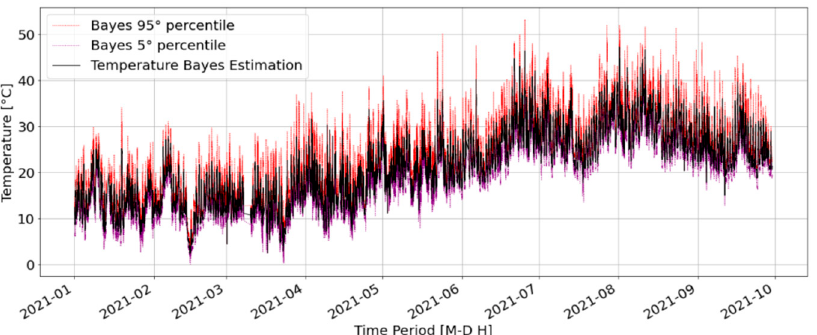
Figure 7. Bayes temperature trend and confidence range in total analyzed period: Bayes equation (black line).